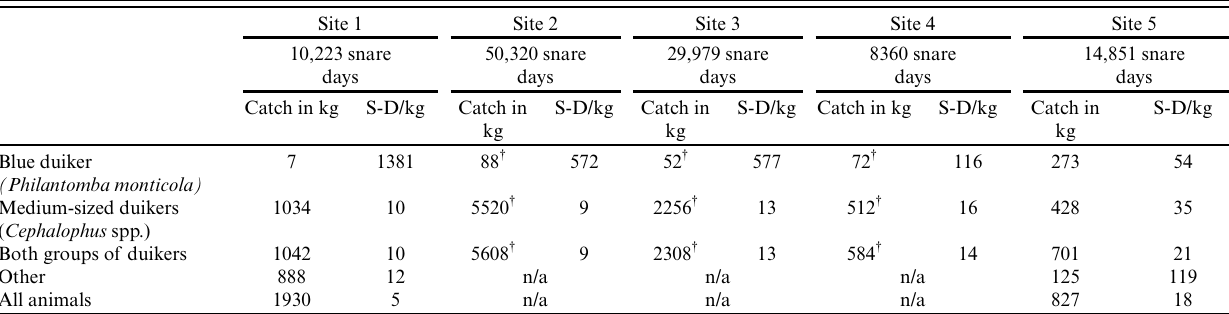
Table 4 . Unit weight catch effort (snare days/kilogram) at sites